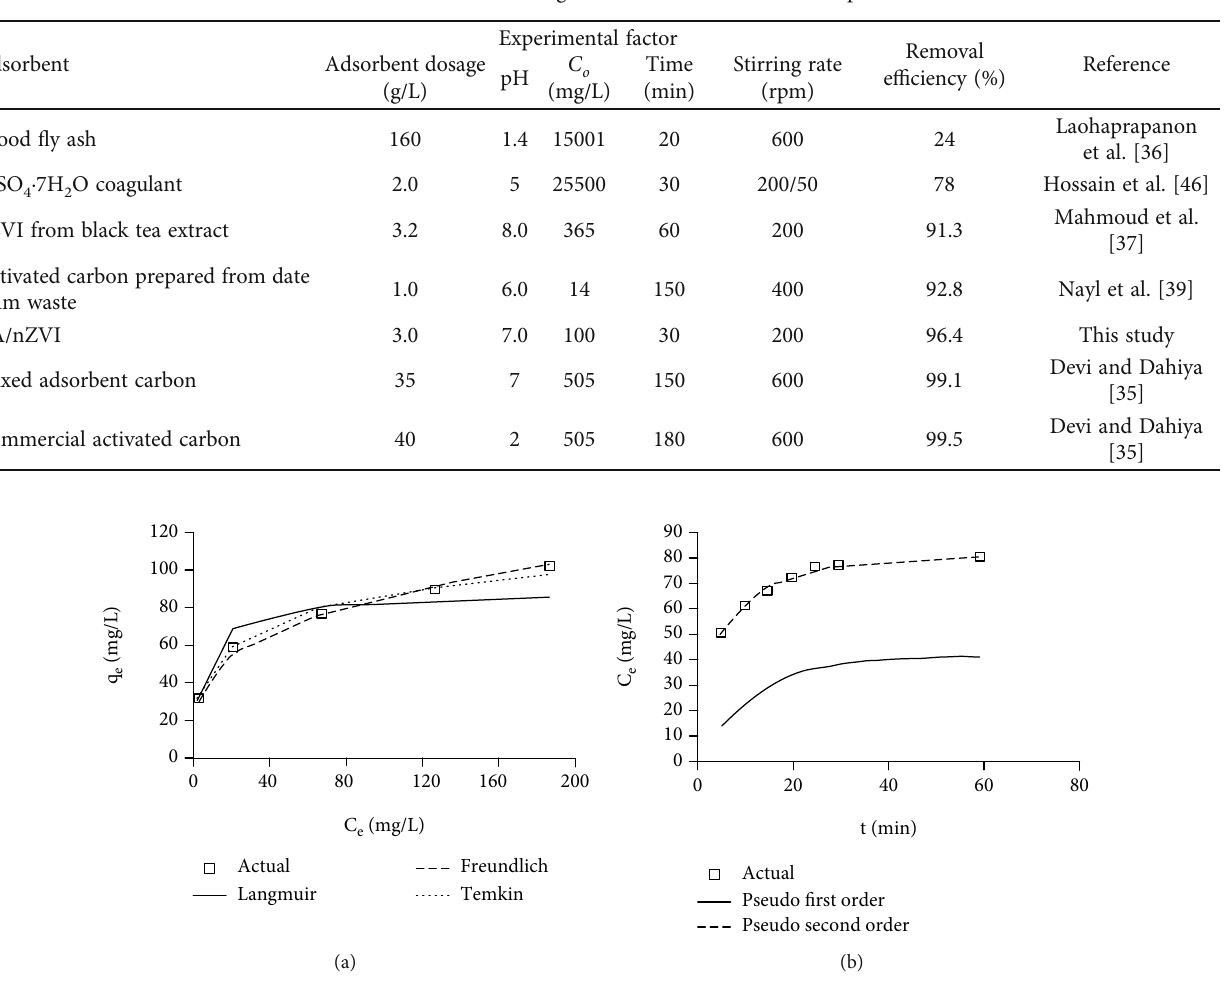
Table 2: Removal e ffi ciencies of BOD using various adsorbent materials reported in literature.